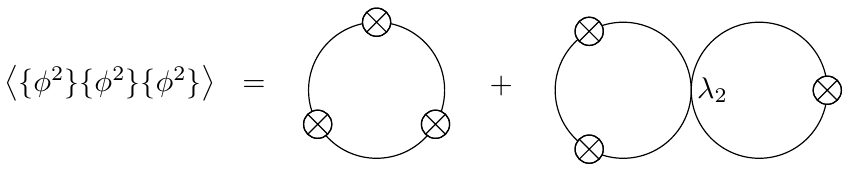
Figure 13 . Leading order diagram for